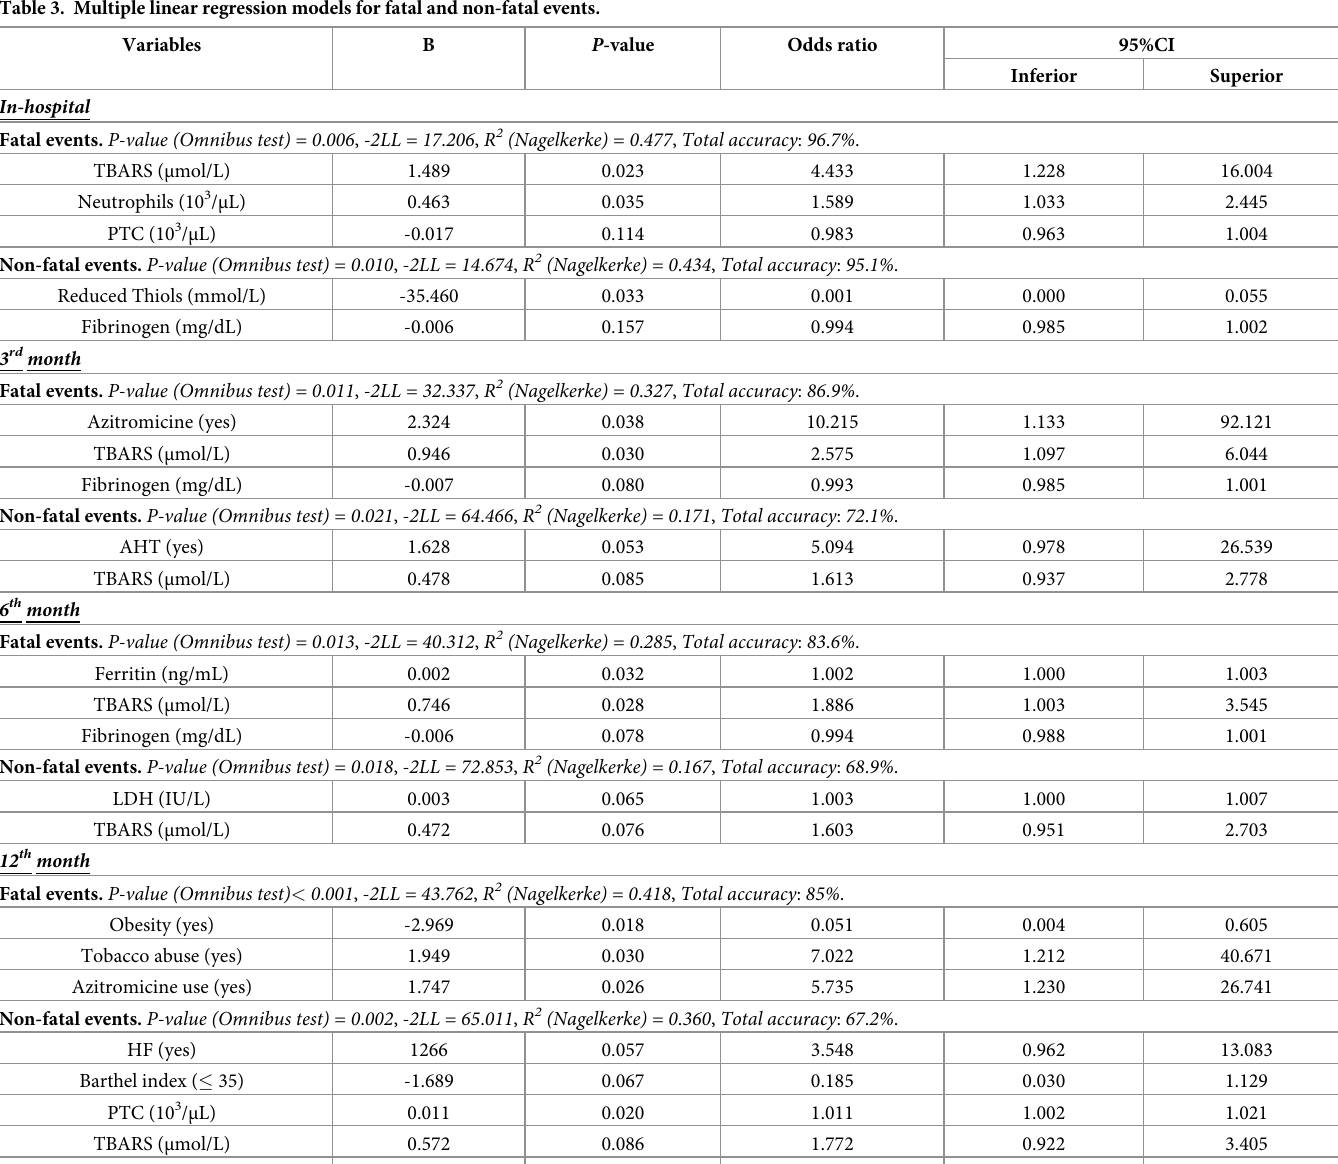
Table 3. Multiple linear regression models for fatal and non-fatal events.